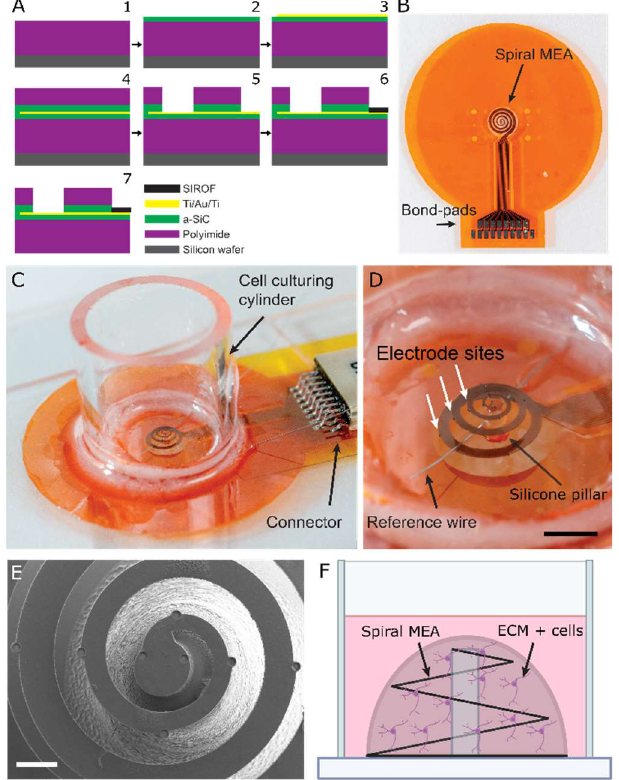
Figure 1. 3D spiral electrode fabrication and assembly. ( A ) The layered fabrication process of 2D spiral MEA and ( B ) the resulting 2D spiral MEA. ( C ) Representative image of fully fabricated and 3D-assembled MEA and ( D ) a close-up view of the same. Electrode sites (example positions indicated by white arrow in D ) appear as small black circles (50-µm diameter) along the length and height of the deployed spiral. Scale bar represents 2 mm. ( E ) Top-down scanning electron micrographs of fully-fabricated and assembled helical MEA. ( F ) Illustration of ECM (collagen and stem cell matrix) droplet residing on and around the spiral MEA, now extended as a helical